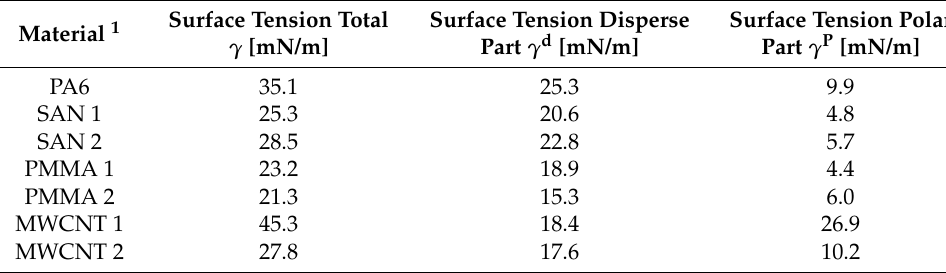
Table 3. Surface tensions γ of the polymers and CNTs calculated for 280 ◦ C (processing temperature during blend preparation). Original data and references are given in Table A1.